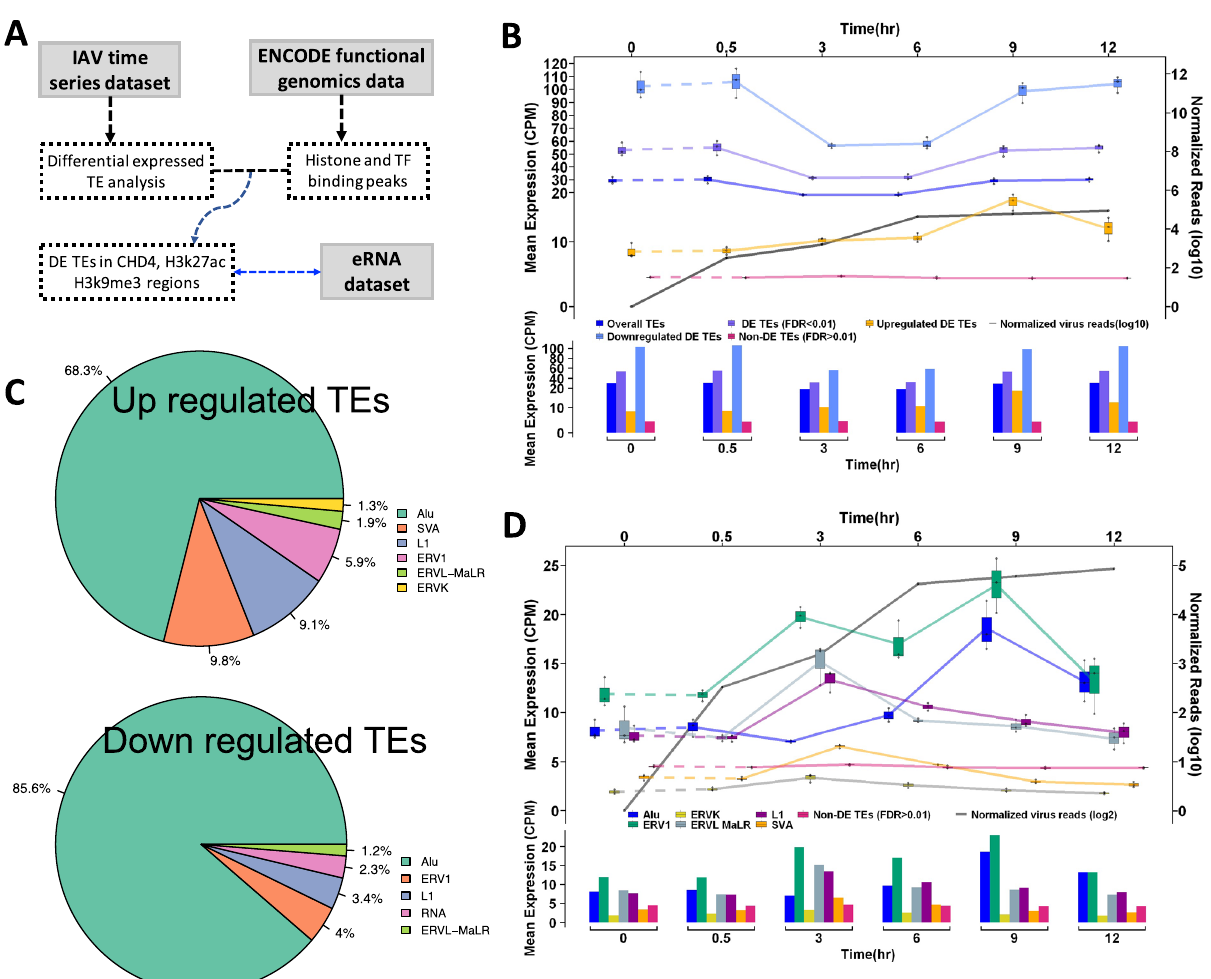
Figure 1. The temporal relationship between up regulated TEs or TE families and virus replication in the IAV early infection. ( A ) Outline of data sources and analysis strategy. ( B ) The dynamics of TE expression in the early stage of IAV infection. The upregulated DE TEs (yellow) correlates to virus replication (black) temporally, the non-DE TEs (pink) remain steady. ( C ) The top TE families in up (upper panel) and down (lower panel) regulated TEs. ( D ) The dynamics of top up regulated TE families at each time point in contrast to Non-DE TEs